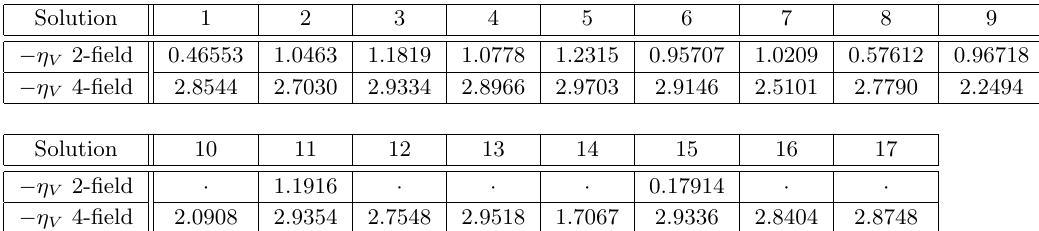
Table 2. Values of (cid:0) (cid:17) V obtained for each of our 17 de Sitter solutions, either with the 2-(cid:12)eld potential V ( (cid:26); (cid:28) ) or the 4-(cid:12)eld one V ( (cid:26); (cid:28); (cid:27) 1 ; (cid:27) 2 ). A dot (cid:1) means that (cid:17) V ( (cid:26); (cid:28) ) >